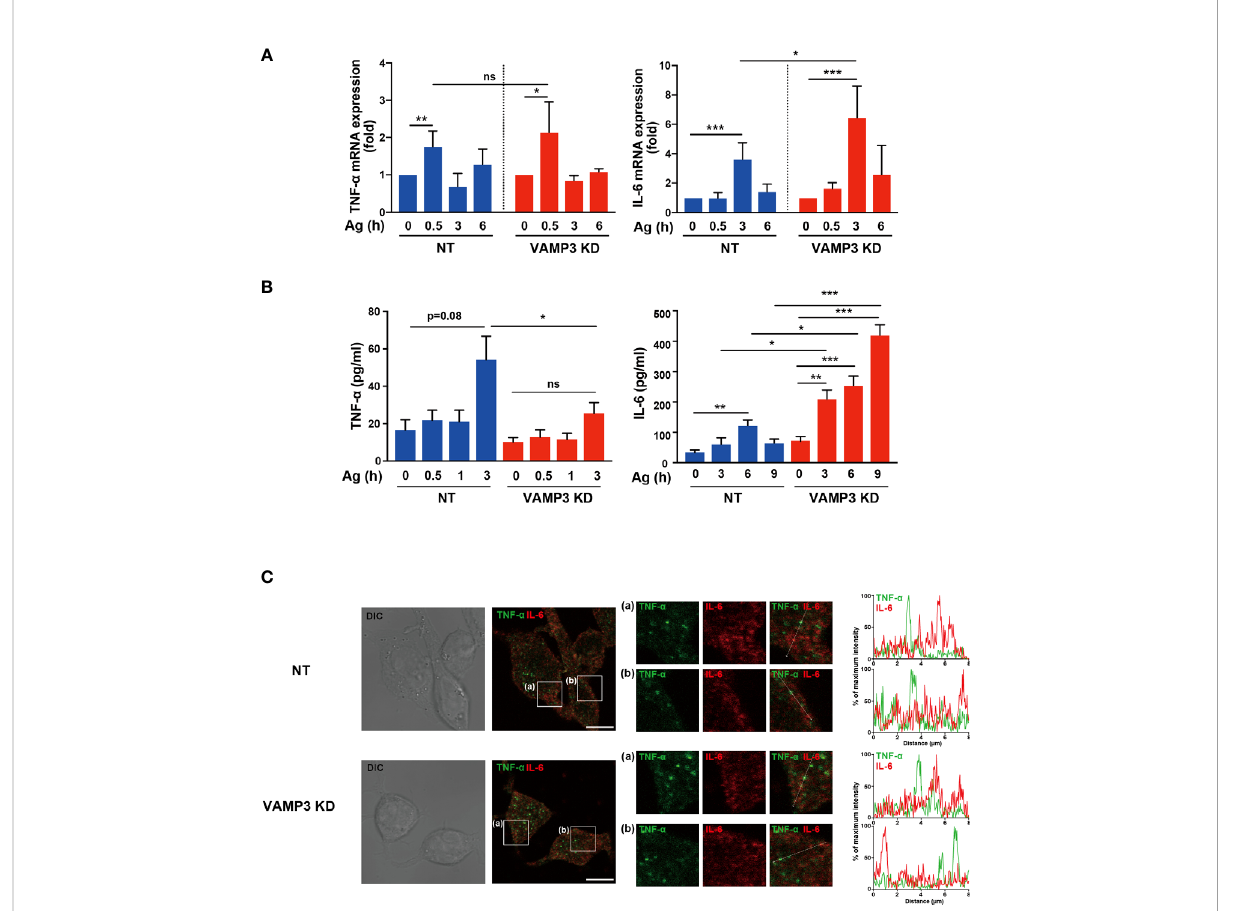
FIGURE 5 Ag-induced release of cytokines are differentially regulated by VAMP3 Ag stimulation (50 ng/ml)-induced cytokine expression and extracellular secretion were analyzed in the cells. (A) Time-dependent expression of TNF- a and IL-6 following Ag stimulation were compared to NT cells and VAMP3 KD cells. (B) Time-dependent secretion of TNF- a and IL-6 following Ag stimulation were analyzed. The supernatant of each cell type was subjected to ELISA. The qPCR data are presented from three to fi ve independent experiments; three to fi ve independent runs of PCR were performed. (C) Intracellular localization of TNF- a and IL-6 were analyzed using confocal microscopy. The large panels show transmitted light image (DIC) and merge image of TNF- a (green) and IL-6 (red) signals. The small panels (a, b) are magni fi ed images of the area within the white square in the large panels. Representative images (magni fi cation ×63, scale bar = 10 m m) and line pro fi les of fl uorescence intensity were obtained from three independent experiments. Time-dependent differences were statistically validated using one-way ANOVA followed by multi-group comparisons. Differences between two groups were analyzed using the two-tailed Student ’ s t-test. NT: control knockdown with a non-targeting shRNA plasmid. Ag: antigen. *p<0.05, **p<0.01, ***p<0.001; ns, not signi fi